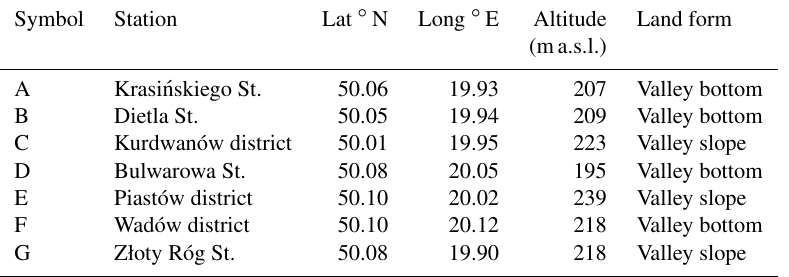
Table 1. Location of air pollution monitoring stations in Kraków. Symbol Station Lat ◦